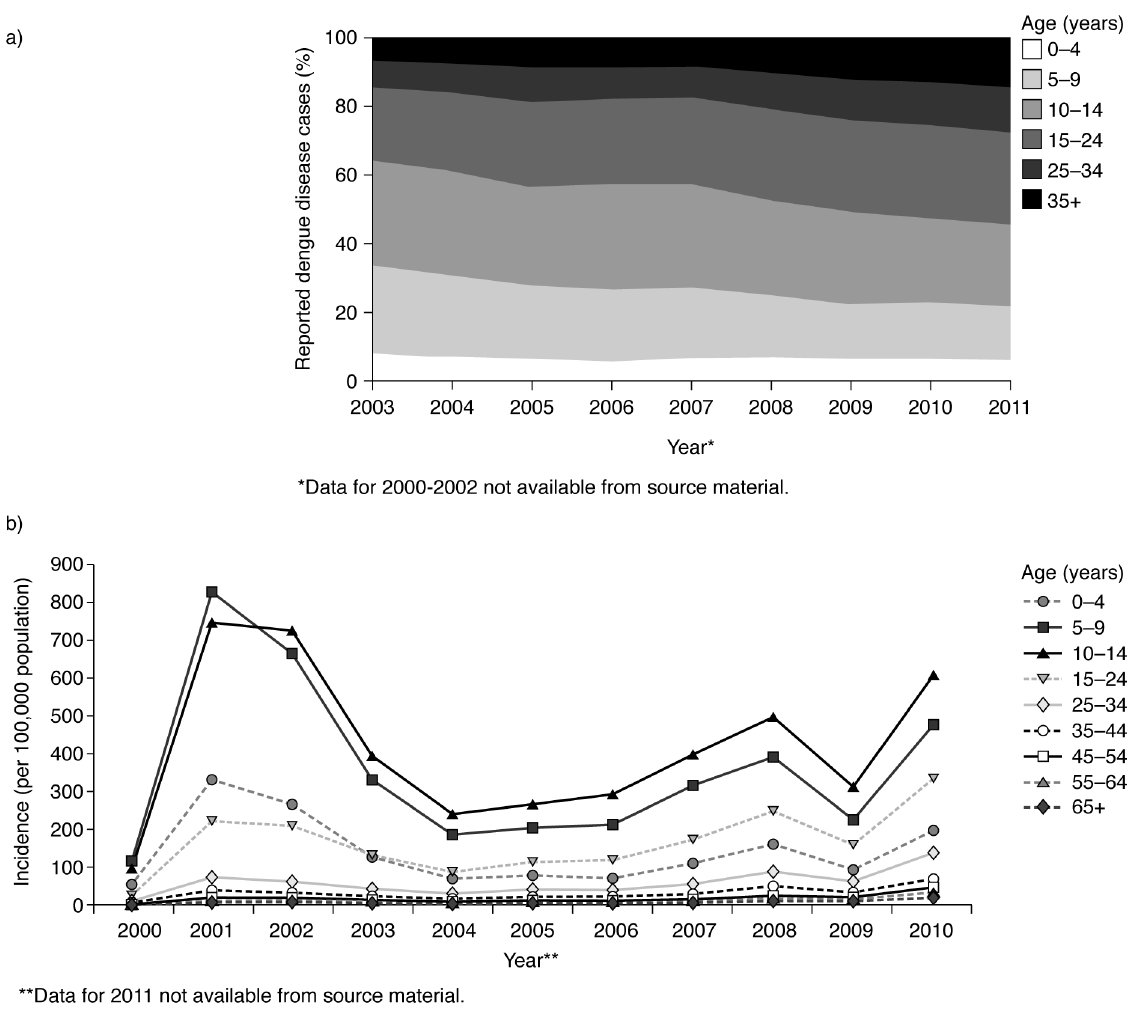
Figure 5. Pattern of reported cases and incidence of dengue disease, by age, Thailand, 2000–2011 [23–34]. Dengue disease is a disease of children and young adults in Thailand. Panel (a) shows that most reported cases between 2003 and 2011* are in individuals aged between 5 and 24 years. There was a shift in age group predominance of dengue disease over the survey period from younger towards older individuals. The age- related incidence per 100,000 population between 2000 and 2010 (b) reveals the highest incidence rates were in those aged 10–14 years. *Age bands for 2011 differ (0–5, 6–10, 11–14, 15–24, 25–34, 35–44, 45–54, 55 + ) and do not match bands for disease numbers: consequently, some 2011 incidence figures are